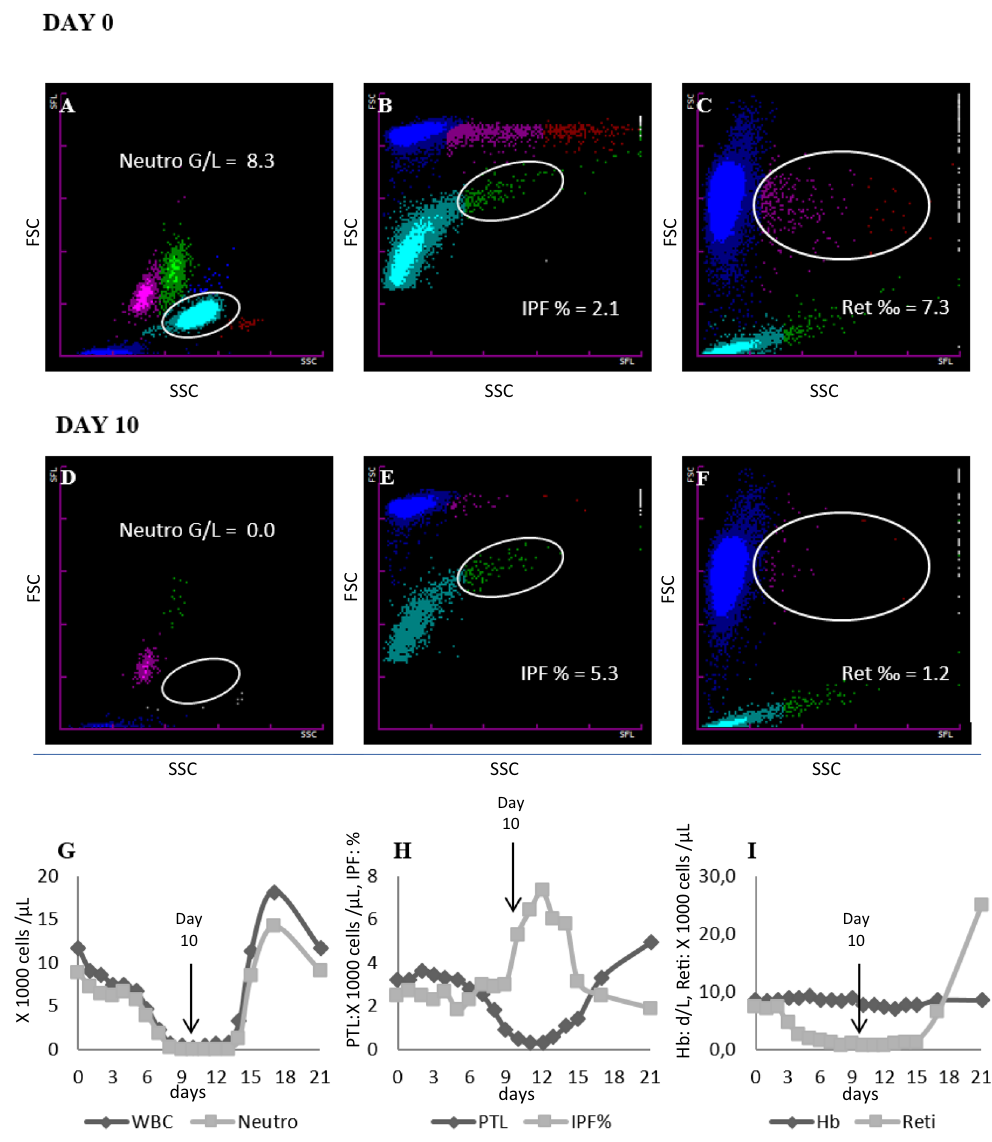
Figure 1. Exemplary patient from the Ewing sarcoma cohort: ( A – C ) neutrophil count, IPF%, and reticulocytes day 0; ( D – F ) neutrophil count, IPF%, and reticulocytes day 10 after chemotherapy application (nadir); ( G – I ) regeneration of neutrophil count, IPF%, and reticulocytes after day 10. A significant IPF% peak can be seen before the increase in neutrophils and